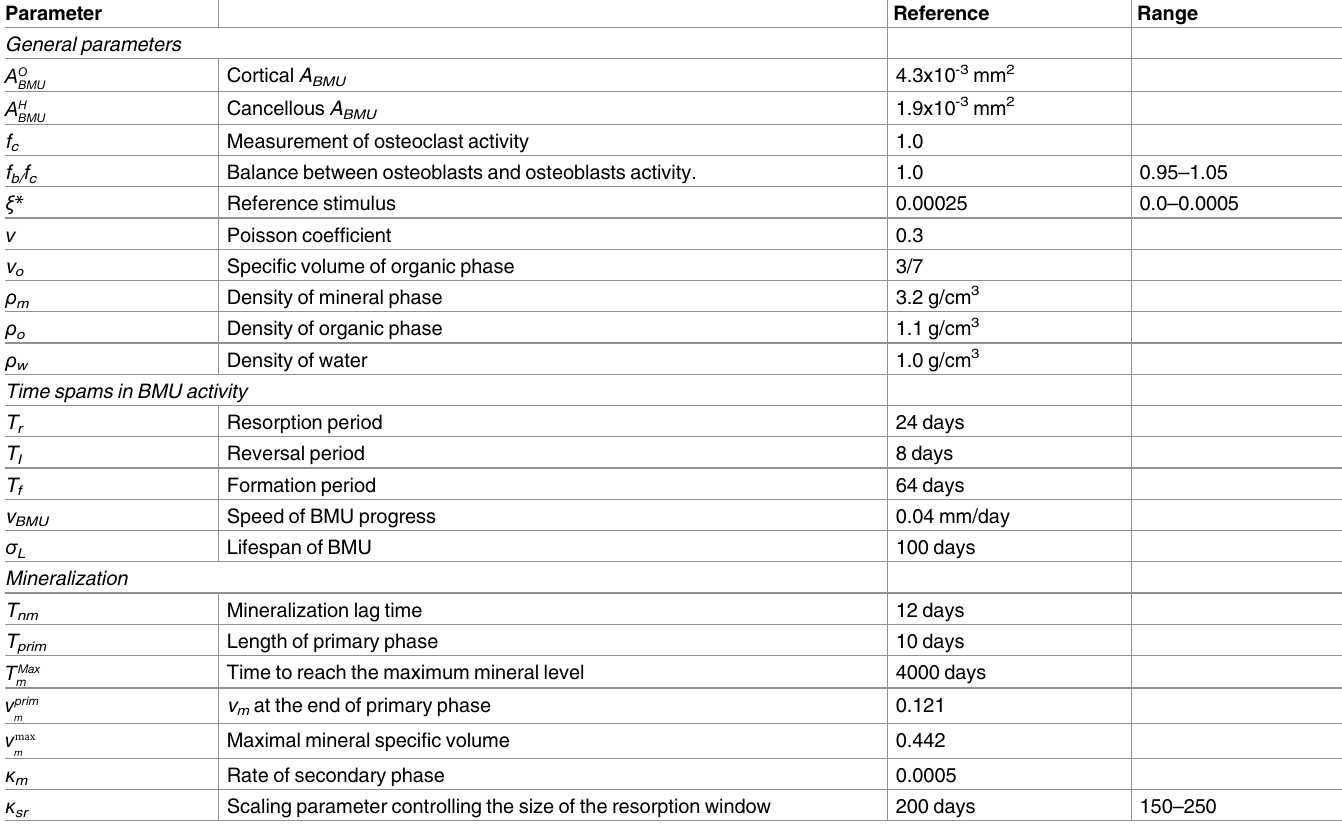
Table 1. Parameters used in the simulations, extracted from